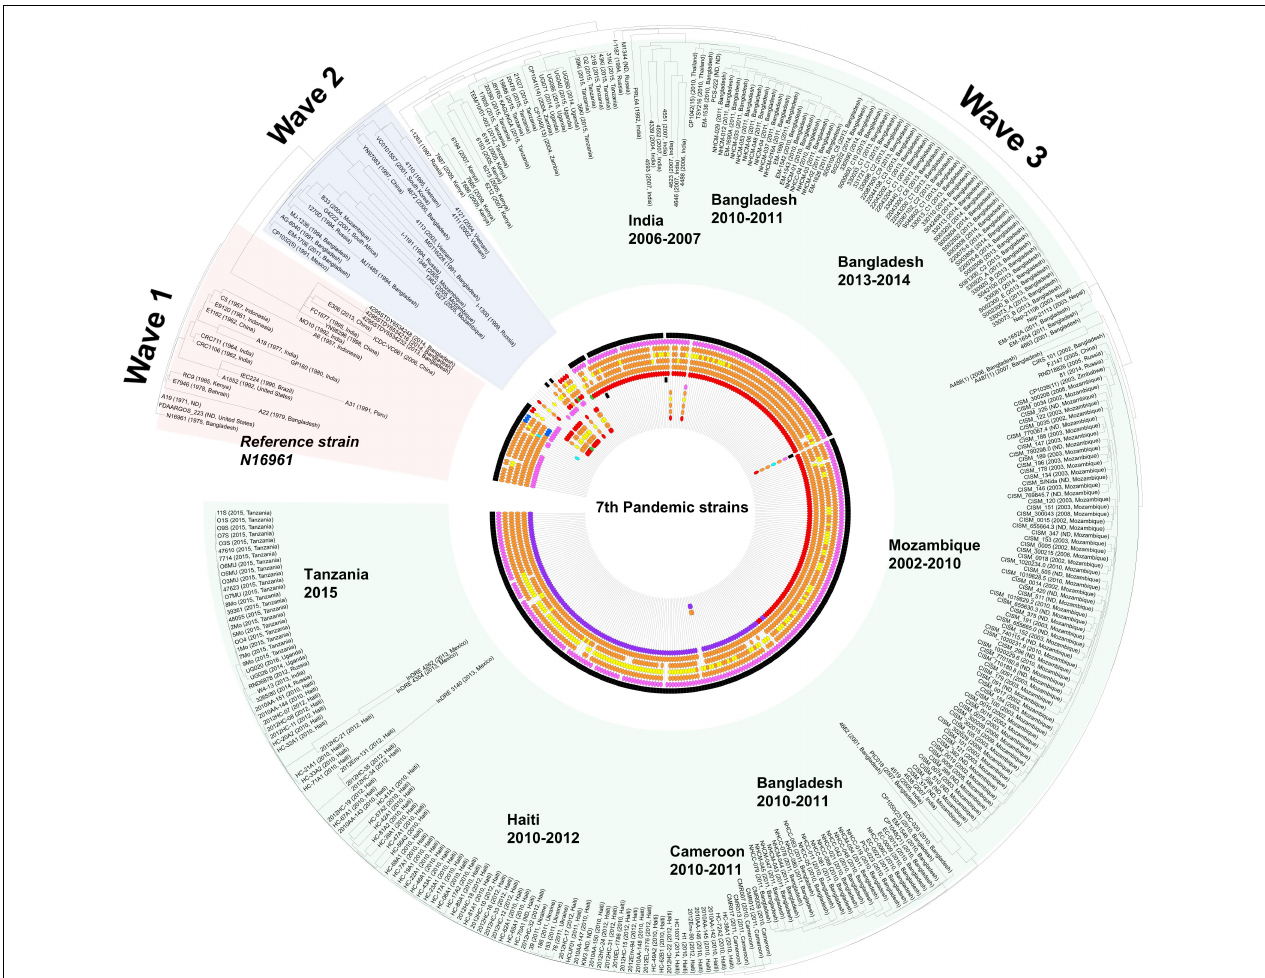
FIGURE 3 | Distribution of V. cholerae 7th pandemic strains harboring various TLC, CTX ϕ , and RS1. The distribution of the CTX prophage and related genetic elements was overlaid on the SNP based on maximum likelihood tree which was constructed using the PhaME tool. The various phage-origin elements were colored red (classical type and ctxB1 ), orange (CTX-1 and ctxB3 ), yellow (CTX-2), blue ( ctxB4 , ctxB5 , or rstR CTX - O 139 ), purple ( ctxB7 ), sea green (US Gulf), pink (RS1 elements), and green (else type). The black color indicates the presence of TLC. The displayed marks of the elements are sequentially drawn from chromosome